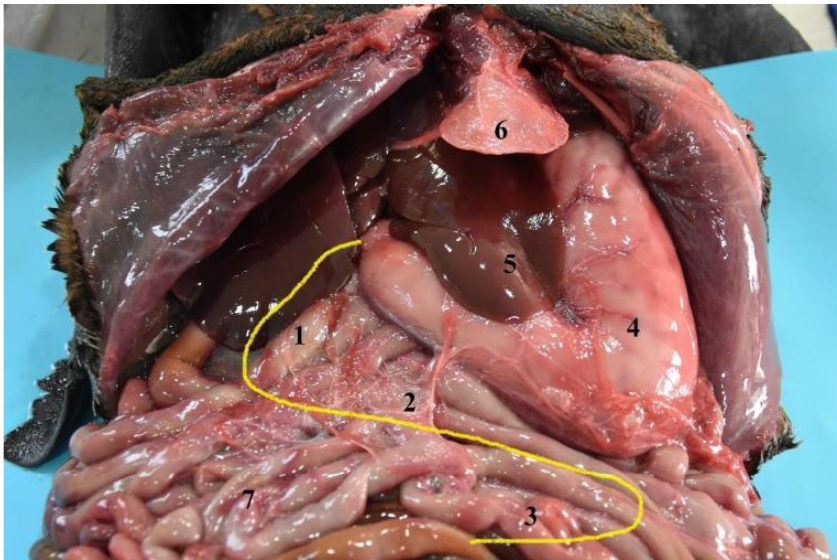
Figure 13. Topography of the duodenum in the abdominal cavity (body in dorsal recumbency). ( 1 ) Descending duodenum; ( 2 ) transverse duodenum; ( 3 ) ascending duodenum; ( 4 ) stomach; ( 5 ) liver; ( 6 ) xiphoid cartilage; ( 7 ) jejunum. The pancreas is formed of two lobes, arranged in a V shape (Figure 14). The right lobe is closely related to the cranial part of the duodenum (Figures 15 and 16). The left lobe is located between the stomach and the transverse colon. In the case of the Arctocephalus australis , this left lobe does not end in relation to the cranial pole of the left kidney.